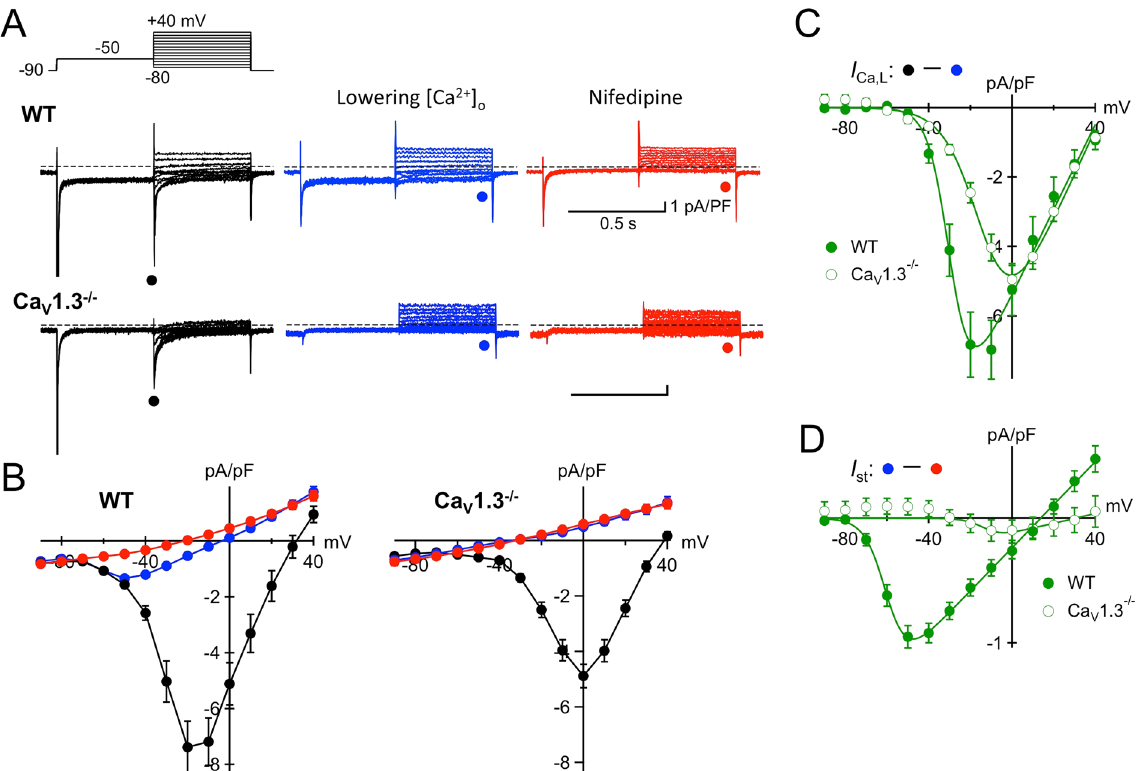
Figure 3. Absence of I st in SAN cells from Ca V 1.3 − / − mice. ( A ) Representative examples of current recordings in SAN cells obtained from wild-type ( upper panel ) and Ca V 1.3 − / − ( lower panel ) mice. Currents were elicited by voltage steps to test potentials between − 80 and + 40 mV (10 mV increments) preceded by a conditioning pulse to − 50 mV from a holding potential of − 90 mV in 1.8 mM [Ca 2 + ] o (control, black ), in 0.1 mM [Ca 2 + ] o solution containing 10 µ M TTX ( blue ) and after applying 1 µ M nifedipine ( red ). ( B ) Average I – V relationships of current densities measured at the time points indicated in ( A ). Data represent the mean ± S.E.M. of wild-type ( left , n = 19) and Ca V 1.3 − / − ( right , n = 18) SAN cells. ( C ), I – V relationships of I Ca,L in wild-type ( closed symbols ) and Ca V 1.3 − / − ( open symbols ) SAN cells, obtained by subtraction of currents after lowering [Ca 2 + ] o from recordings in the control solution. ( D ) I – V relationships of I st in wild-type ( closed symbols ) and Ca V 1.3 − / − ( open symbols ) SAN cells, measured as the nifedipine-sensitive current in 0.1 mM [Ca 2 + ] o